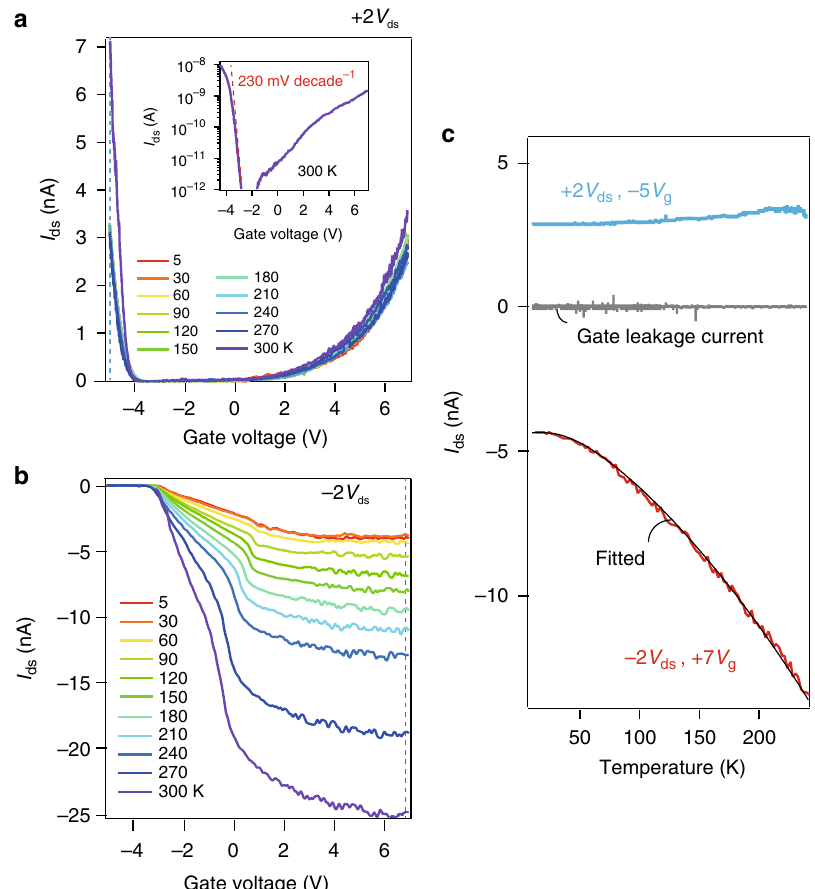
Fig. 4 Temperature dependence of transfer curves in a MoS 2 TC-FET. a , b Transfer curves at different temperatures for the device shown in Fig. 2, at drain source voltages V ds = +2 and − 2 V, respectively. Inset in a is a log scale of the fi eld effect curve. c Line traces of temperature dependence of I ds at fi xed gate voltage along the blue and red dashed lines in Fig. 5a, b, respectively. Gray solid line indicates the gate leakage current during the same measurement. Solid fi tting line in Fig. 5c is fi tted using Eq. (1) in the main